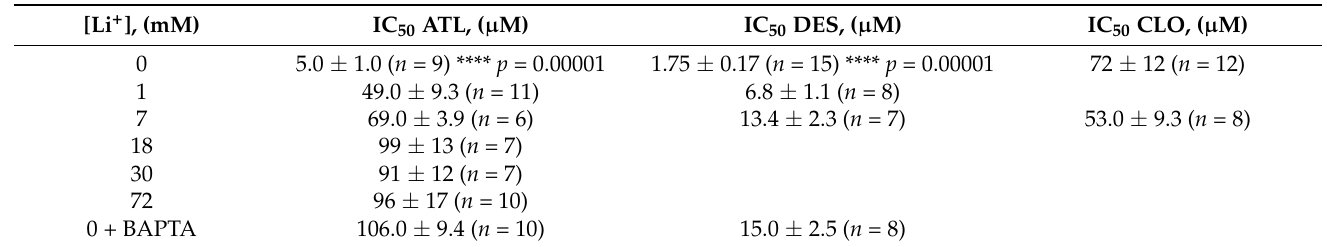
Table 2. An effect of different [Li + ]s on the IC 50 values for inhibition by tricyclic antidepressants of NMDAR